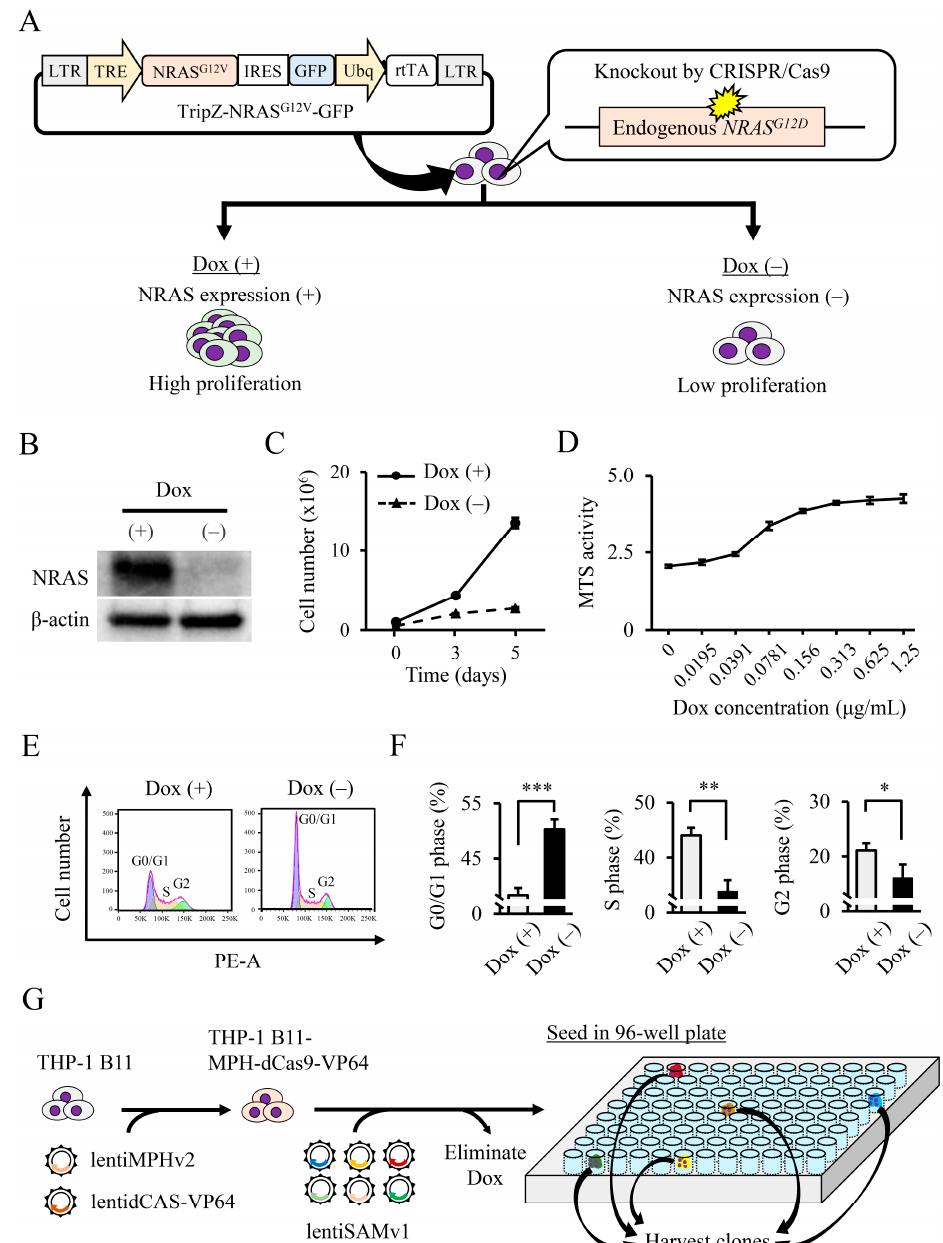
(Figure 1E,F). CRISPR activation screening was applied to the THP-1 B11 cells, in which the proliferation activity could be controlled with or without Dox. As shown in Figure 1G, THP-1 B11-MPH-dCas9-VP64 cells constitutively expressing the MS2-P65-HSF1 (MPH) activator helper complex and dCas9-VP64 were generated. After introducing a pooled whole-genome CRISPR activation library into these cells and 2 weeks of drug selection, Dox was removed. The removal of Dox caused many cells to stop proliferating, but some cells proliferated and formed cell colonies. Five such cell colonies were clustered on a 96-well plate and became established (SAM 1–5). After extracting genomic DNA from each of SAM 1–5, an analysis of the integrated gRNA sequences revealed an average of four genes per clone and 21 genes overall (Table 1).